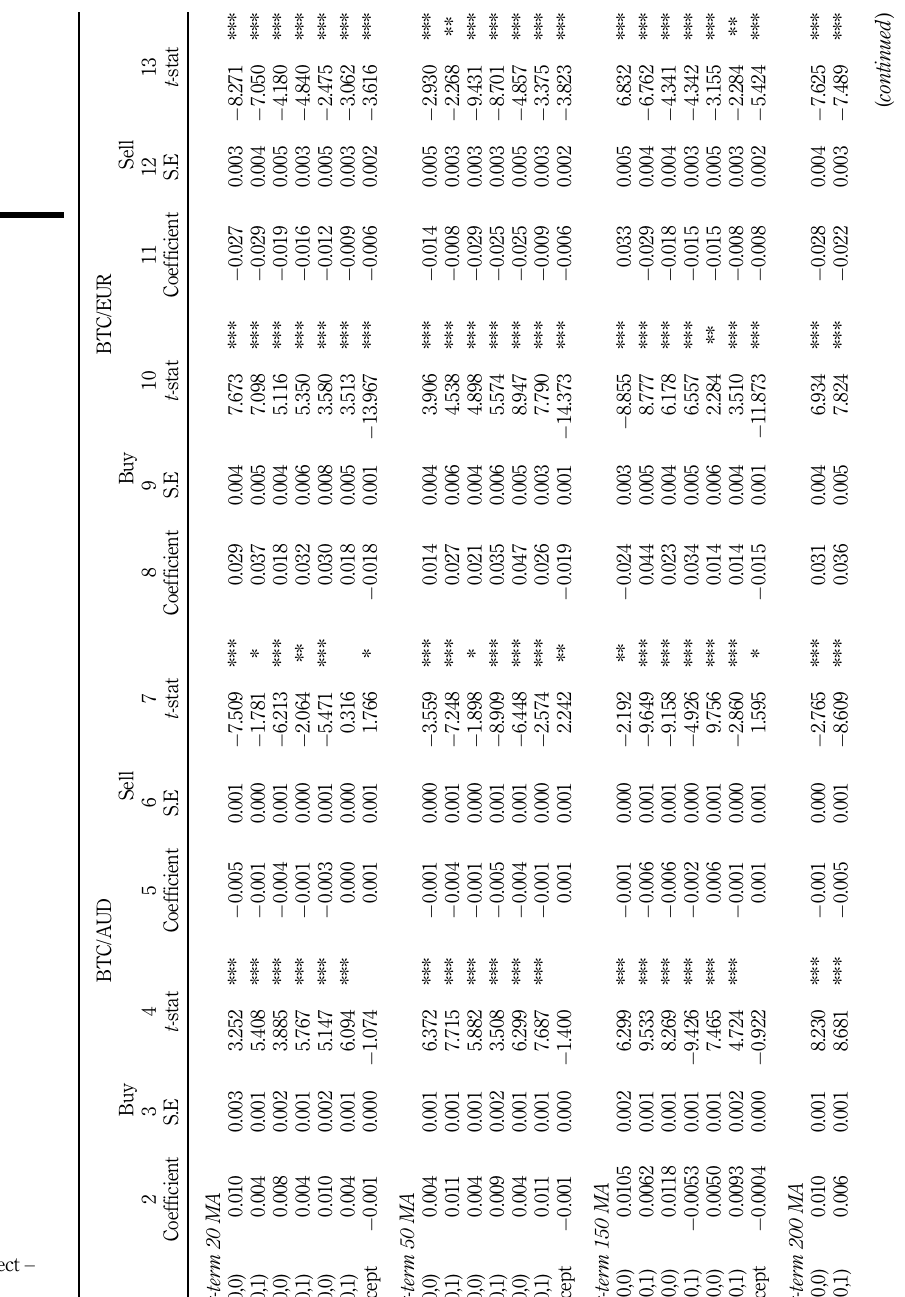
Table 8. Momentum effect